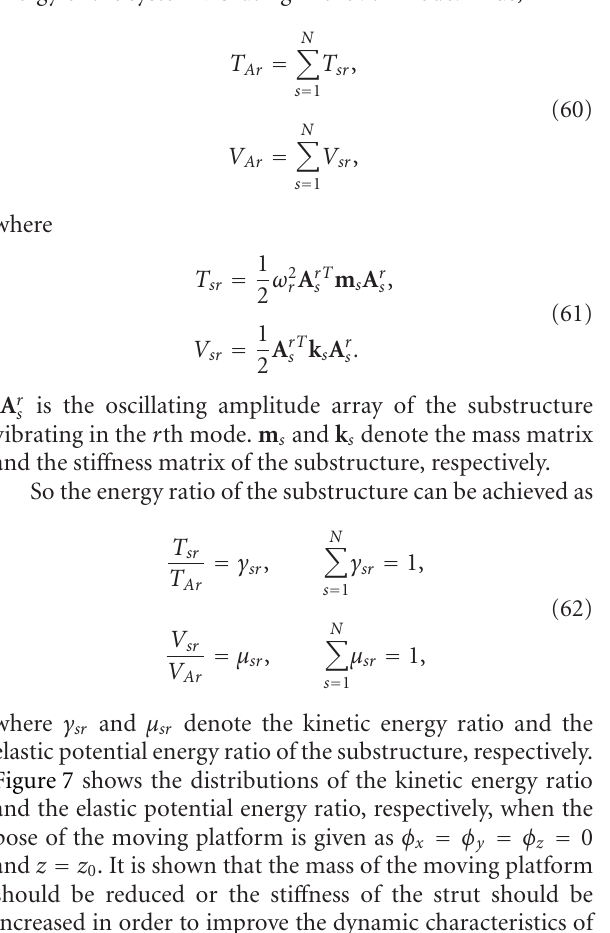
Table 4: The mass parameters of the manipulator